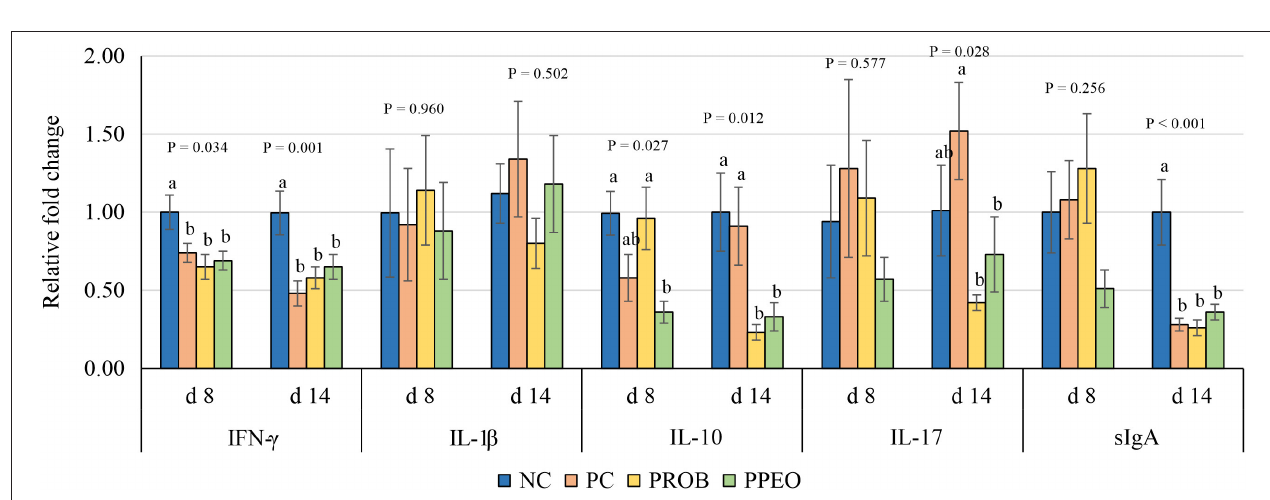
FIGURE 1 | Relative mRNA abundance of tight junction proteins in the jejunum of broiler chickens on day (d) 8 and 14. Birds reared under a naturally occurring necrotic enteritis challenge model. Treatments include: NC (negative control): corn-soybean meal basal diet; PC (positive control): NC + 20g virginiamycin (453g Stafac ® 20)/ton diet; PROB (Probiotic): NC + B. licheniformis spores at the level of 227 g/ton diet; PPEO (probiotic/prebiotic/essential oil supplement): NC + 453 g/ton of a supplement containing B. licheniformis spores, mannan-oligosaccharides, β -glucans (1,3 and 1,6), capsaicin, and curcuma. Values are represented as a n -fold difference relative to the calibrator (NC). Results are given as means ( n = 8) for each treatment. Error bars indicate standard errors. For each gene and sampling day, columns with different letters are significantly different ( P < 0.05).